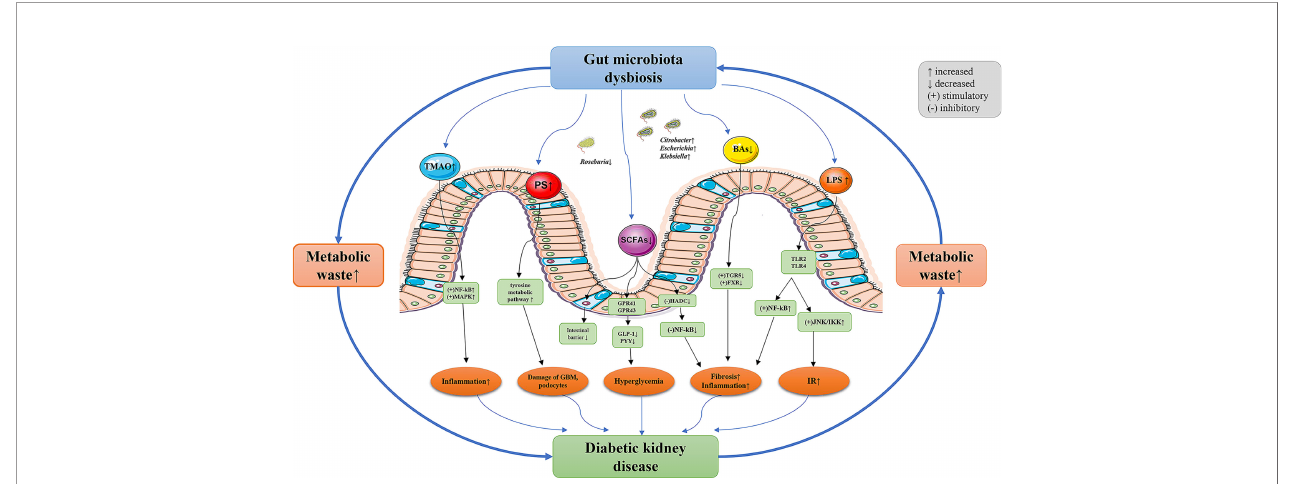
FIGURE 4 | The potential mechanism between gut dysbiosis and DKD. The decreased glomerular fi ltration rate of DKD patients leads to the accumulation of metabolic waste, which enters the intestinal lumen through the intestinal wall and results in gut dysbiosis. The composition and function of gut microbiota in patients with DKD signi fi cantly varied, resulting in the destruction of intestinal epithelial barrier function. Gut microbiota metabolites enter the blood and further aggravate the progression of DKD through a variety of pathways. TMAO, trimethylamine-N-oxide; PS, phenyl sulfate; SCFAs, short-chain fatty acids; BAs, bile acids; LPS, lipopolysaccharide; NF- k B, nuclear factor kappa-B; MAPK, mitogen-activated protein kinases; G-protein-coupled receptors (GPRs), such as GPR41 and GPR43; GLP-1, glucagon-like peptide-1; PYY, peptide YY; HADC, histone deacetylases; TGR5, Takeda G-protein receptor 5; FXR, farnesoid X receptor; TLR, toll-like receptors; JNK, c-Jun N-terminal kinase; IKK, IkappaB kinase; IR, insulin resistance; GBM, glomerular basement membrane; DKD, diabetic kidney